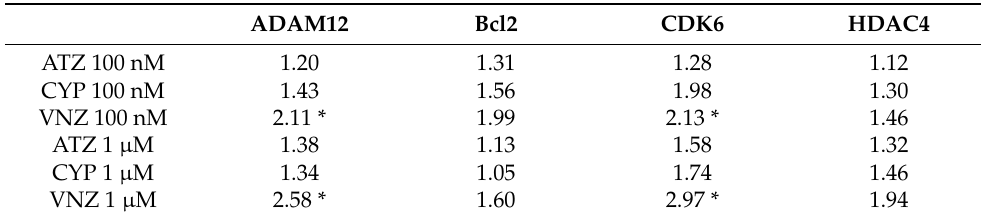
Table 2. qRT-PCR validation of gene expression in differentiated SH-SY5Y cells, treated with ATZ, CYP, and VNZ. Quantitative analysis was performed by the 2 −ΔΔ Ct method and vehicle samples were considered as the calibrator of the experiment.